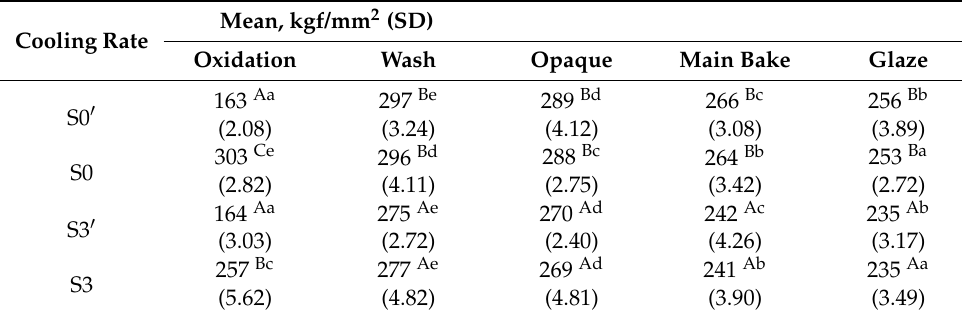
Table 6. Mean surface hardness (HV0.3) and standard deviations.